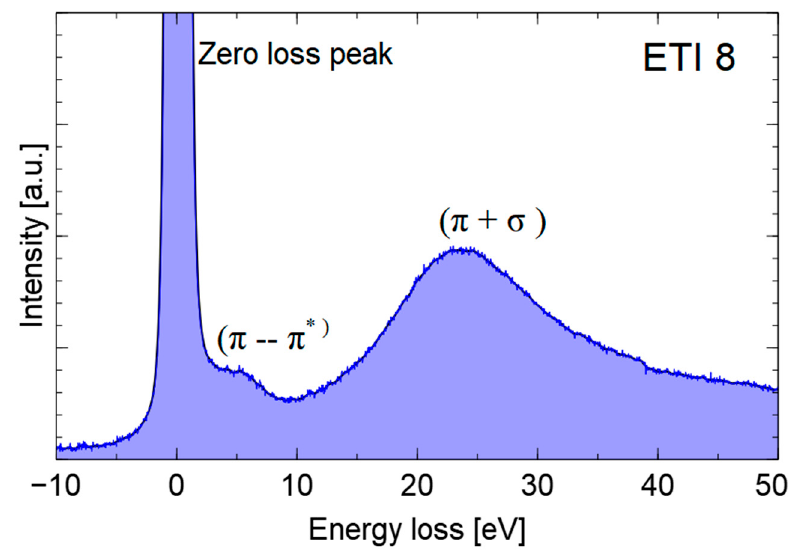
Figure 4. An example of the EELS spectrum of young ethylene soot. The range of low energy losses. The position of this band is 27 eV for highly oriented pyrolytic graphite (HOPG),